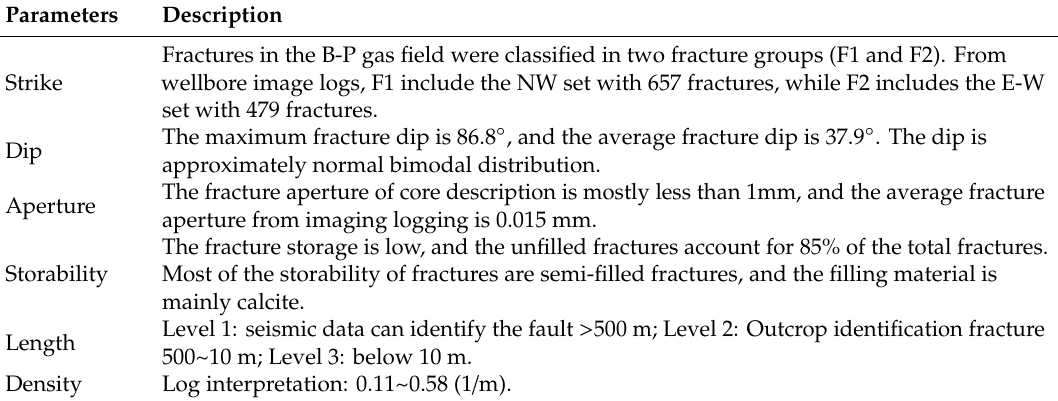
Table 1. Summary of fracture attributes observed from the wells 1D analysis.